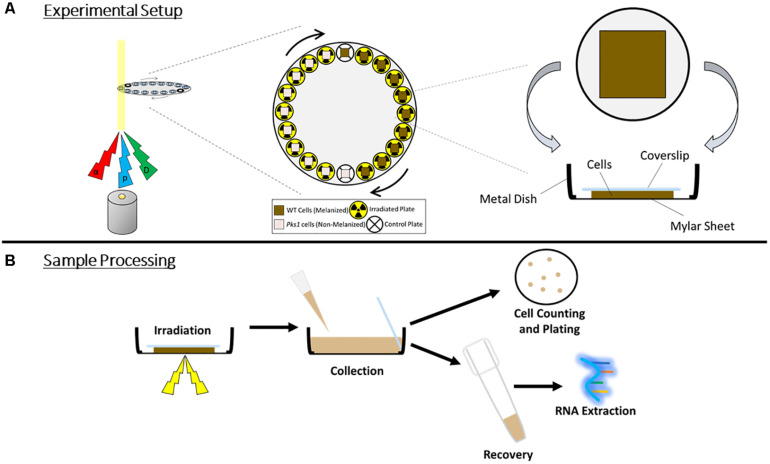
(A) Irradiation setup. Particles (α, alpha; p, proton; D, deuteron) were produced and passed through cell sample chambers placed along the circumference of a disk, which rotated automatically to provide each sample with an even exposure. For control samples, particle source was momentarily stopped as the cells passed through the beam. (B) Overview of sample processing during and post-irradiation, demonstrating the orientation of the cells and the coverslip within the chamber, and the harvesting of cells for survival measurements and RNA extraction.